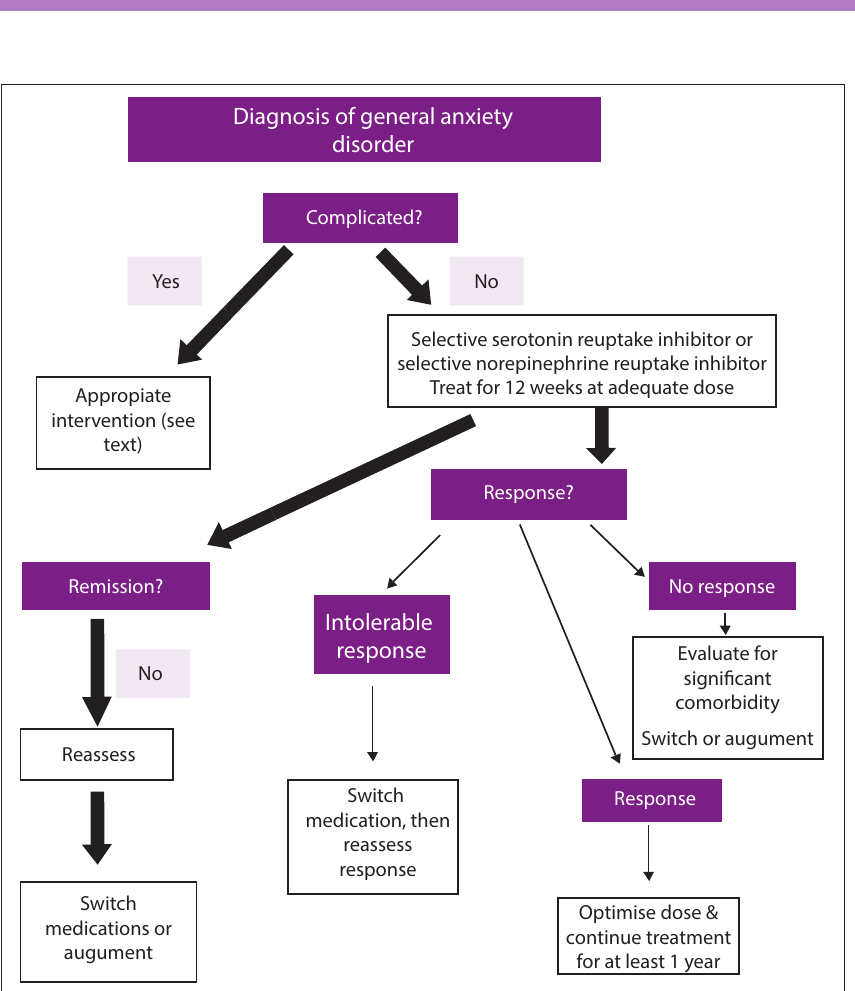
Fig. 1. Algorithm for pharmacotherapy of generalised anxiety disorder.